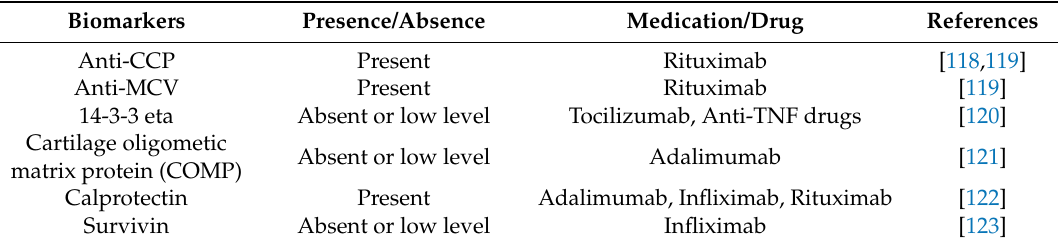
Table 4. Potential predictive biomarkers for rheumatoid arthritis